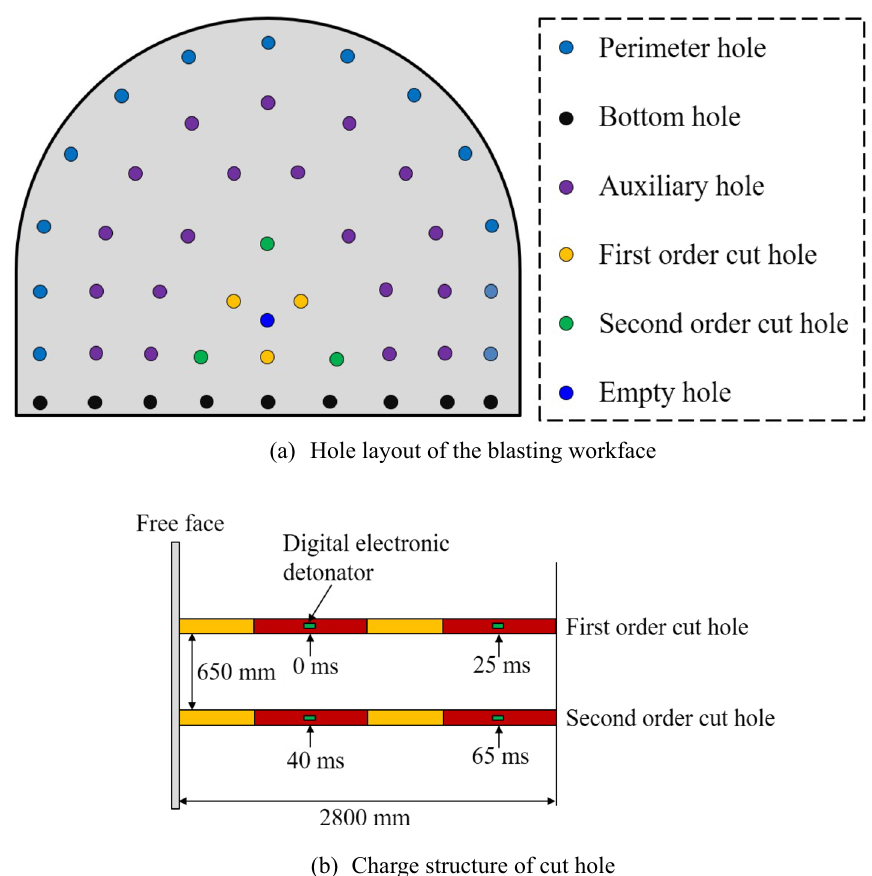
(b) Charge structure of cut Fig. 20 Blasting design drawing. a Hole layout of the blasting workface; b Charge structure of cut hole